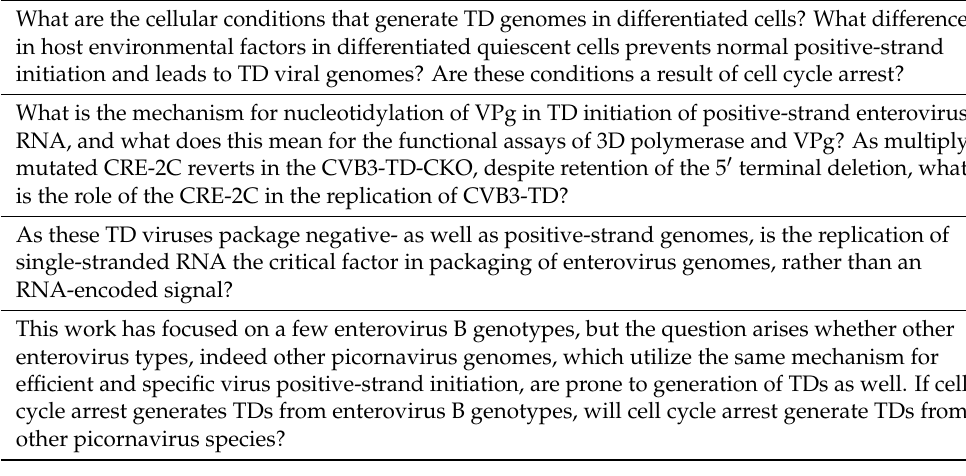
Table 1. Unresolved questions concerning TD